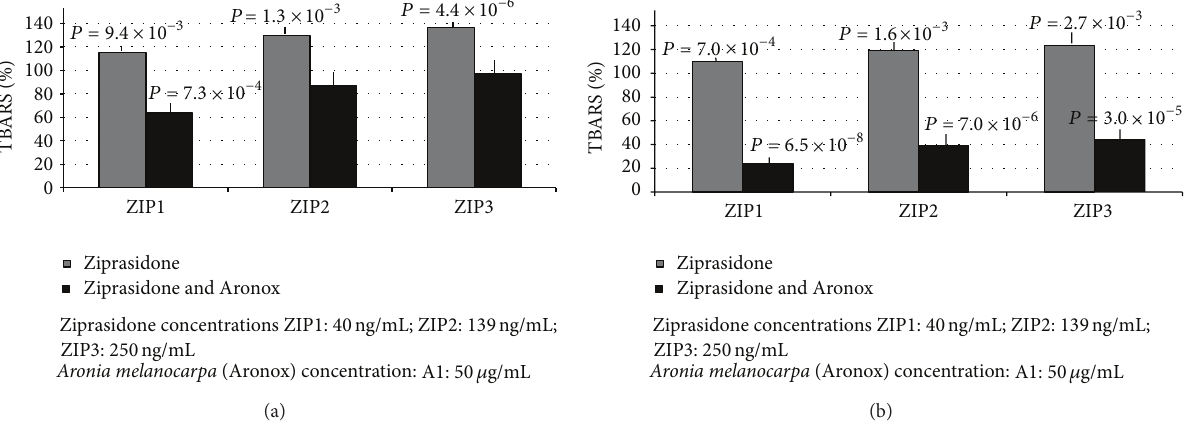
Figure 2: (a) The effects of ziprasidone alone (gray columns) and ziprasidone at the presence of 50 𝜇 g/mL Aronox (black columns) on the lipid peroxidation (TBARS) in plasma after 1h incubation. TBARS level in control plasma (without ziprasidone and Aronox) was expressed as 100%. The level of TBARS in control plasma (1h: 0.712 ± 0.04 𝜇 mol/l). (b) The effects of 24 h incubation of plasma with ziprasidone and ziprasidone with Aronox (50 𝜇 g/mL) on the level of lipid peroxidation measured as TBARS. The TBARS level in control plasma (without ziprasidone and Aronox) was expressed as 100%. The level of TBARS in control plasma (24 h: 1.564 ± 0.06 𝜇 mol/l).